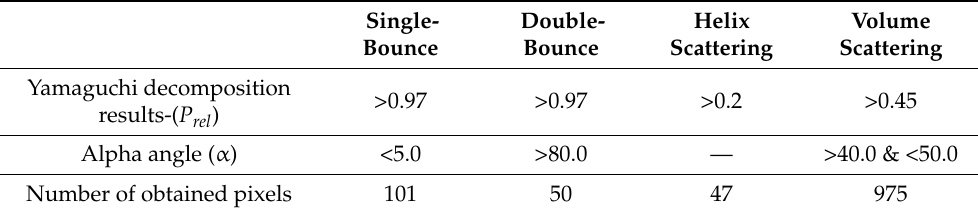
Table 8. Thresholds for the Yamaguchi parameters and alpha angle.